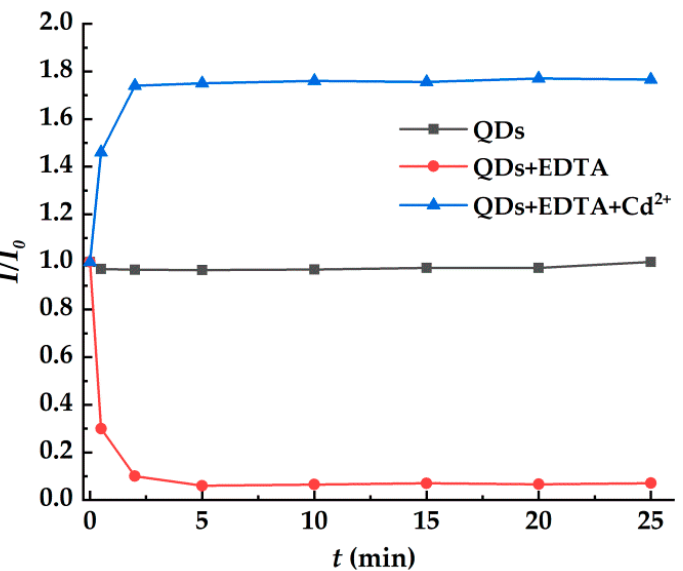
Figure 6. The change trend of I / I 0 for the system of QDs, EDTA-QDs, EDTA-QDs + 20 µmol/L Cd 2+ with incubation time ( t ).